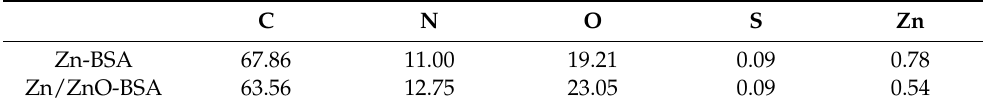
Figure 10. High-resolution XPS spectra for samples after 21 days immersion in SBF/BSA, bare Zn: ( a ) C1s, ( b ) N1s, and ( c ) O1s; and Zn/ZnO: ( d ) C1s, ( e ) N1s, and ( f ) O1s. Table 3. Atomic concentration in XPS spectra.